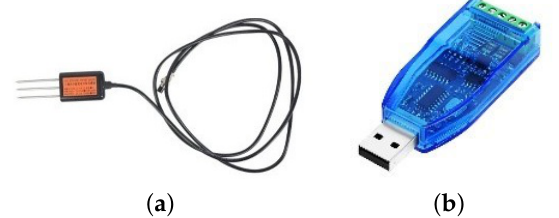
Figure 6. ( a ) Water content sensor (the rated voltage was 5 V); ( b ) signal conversion device (converting the RS485 signal to USB